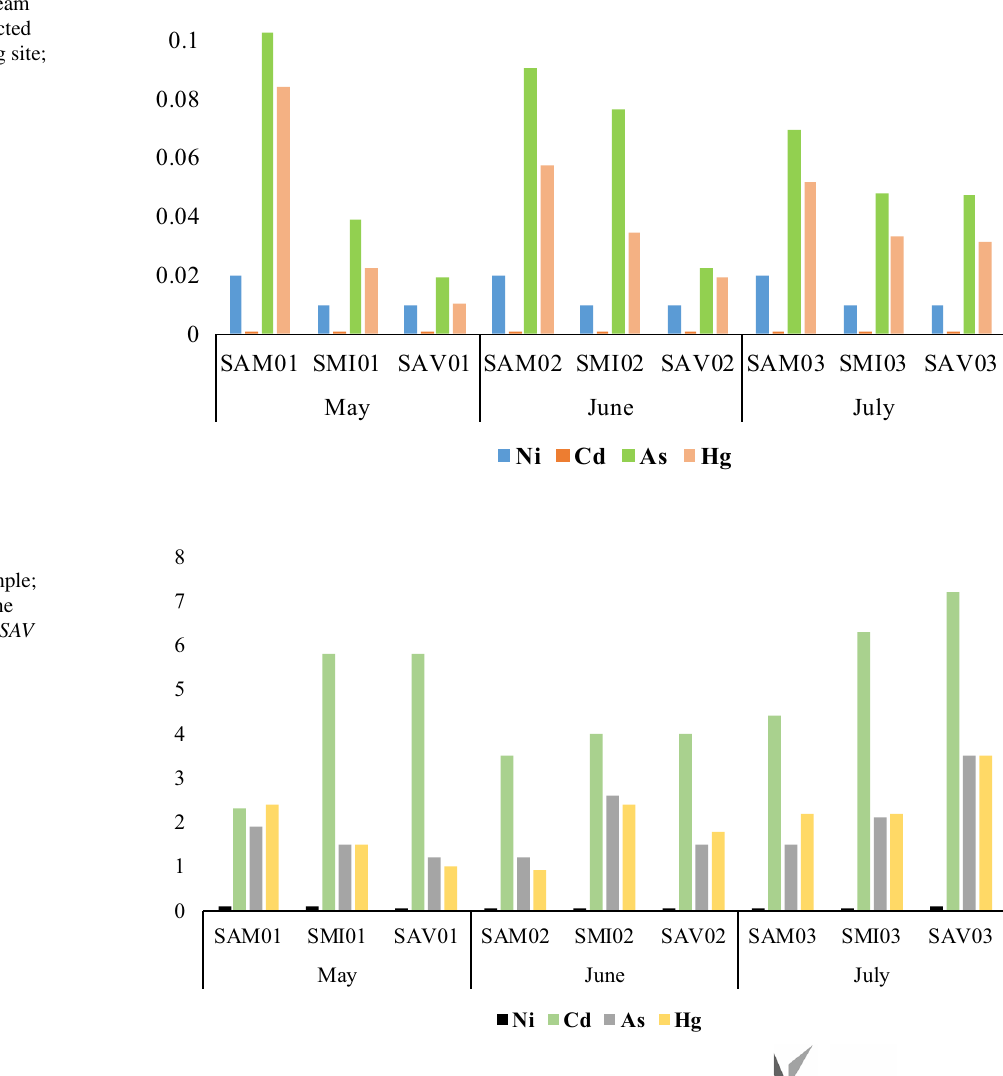
Fig. 9 Enrichment factor of the sediments. SAM Usptream sample; SMI Sample collected in the middle of the mining site; SAV Downstream sample